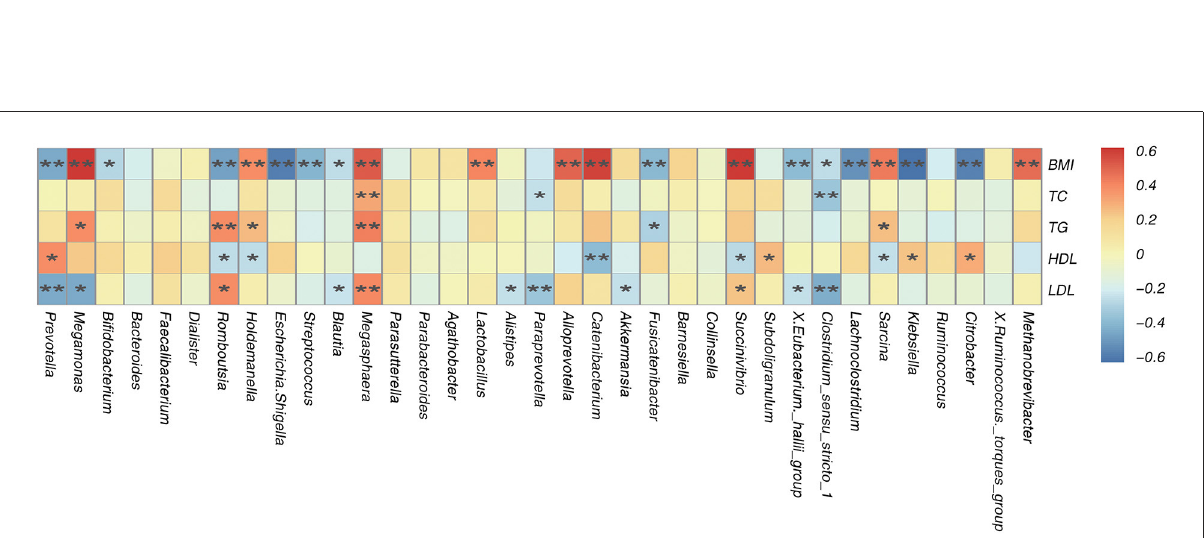
FIGURE6 Spearman’s association analysis of bacterial genera and BMI, TC, TG, HDL, and LDL. r indicates Spearman’s correlation coefficient. Cells are colored based on the value of r between significantly altered genera and body mass index (BMI), total cholesterol (TC), tri glyceride (TG), high-density lipoprotein cholesterol (HDL-C), and low-density lipoprotein cholesterol (LDL-C). Red represents a significantly positive correlation, blue represents a significant negative correlation, and yellow represents no significant correlation. * p < 0.05; ** p <